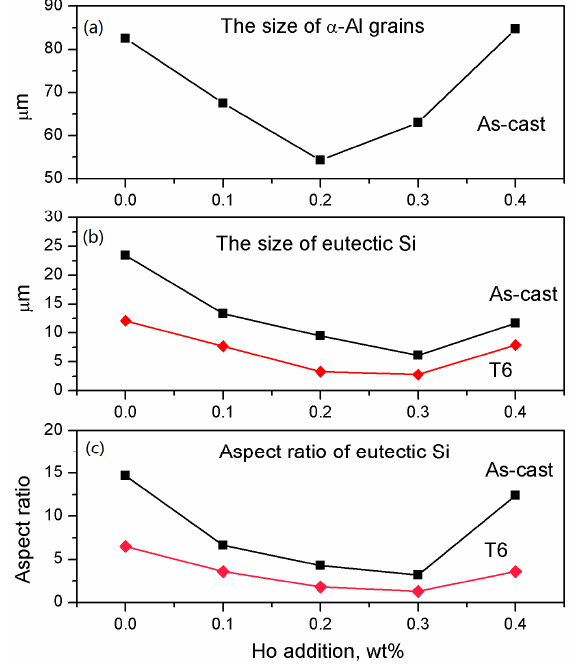
Figure 3. Variations of the statistical parameters of the size and morphology of the α -Al crystals and Si phases, ( a ) equivalent size of α -Al crystals; ( b ) equivalent size of Si phases; ( c ) aspect ratio of Si phases.